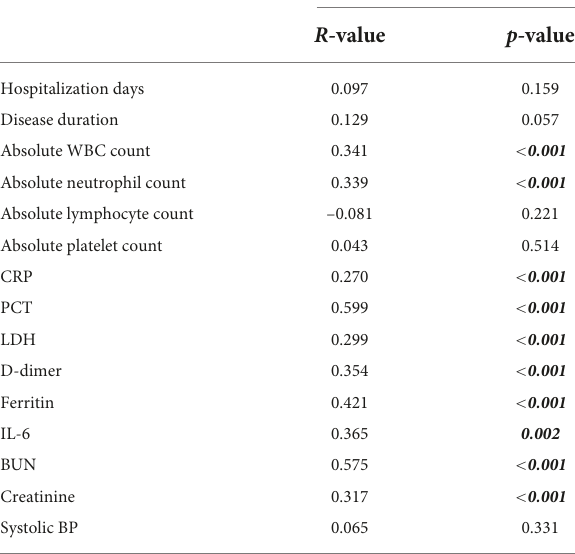
TABLE 4 Correlations of A-DROP with clinical and laboratory